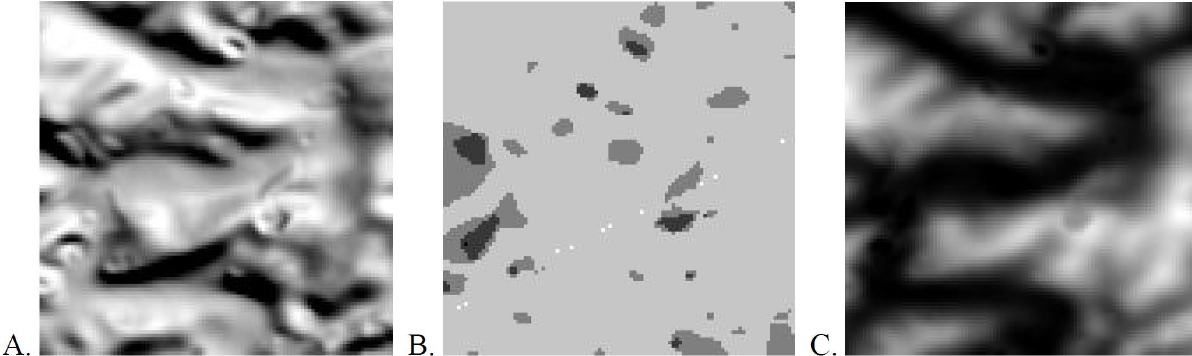
Figure 3. Example of “pit” artifacts; (A) shaded relief, (B) clear relation to the stack (scene) number boundaries, (C) appearance in ASTER GDEM represented as gray scale image (originally appeared in